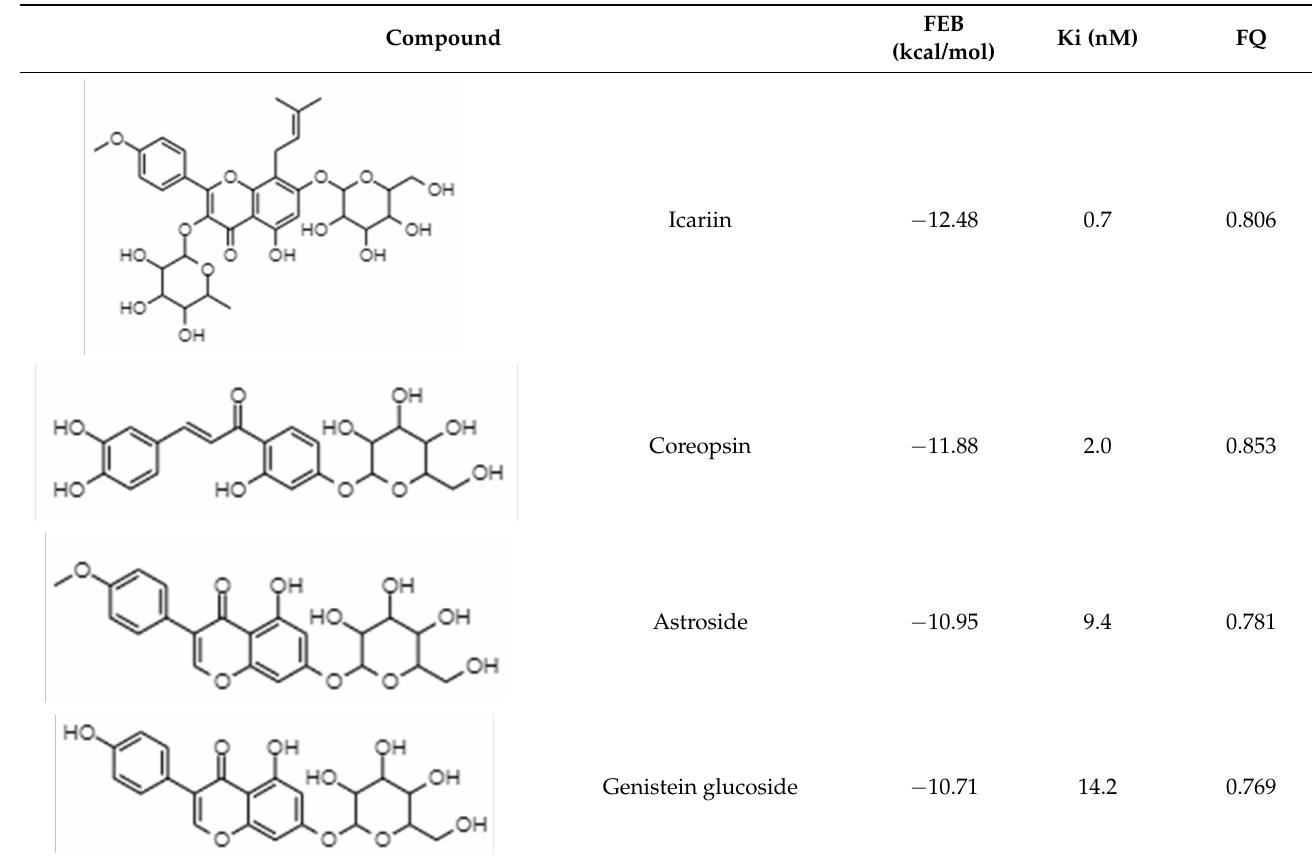
Table 3. Docking results—glucosides (ascending